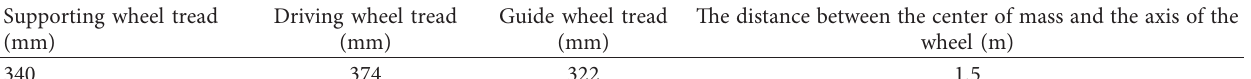
Table 5: Parameters of the test vehicle.